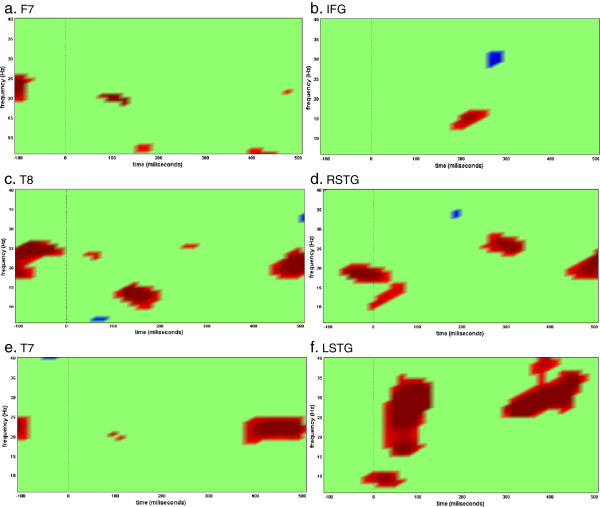
Statistic tests (p<0.05) carried out on the time-frequency representation of current dipoles in the 3 ROIs analyzed for the auditory versus visual condition. t-test over time-frequency bins of 11 subjects (10 degrees of freedom). Time frequency analysis was done over activity localized on the cortex in b) IFG, d) RSTG and f) LSTG as well as over channel level activity in a) F7, c) T8 and e) T7. In red: bins whose statistics are greater than the null hypothesis of zero mean. In blue: bins whose statistics are smaller than the null hypothesis of zero mean.